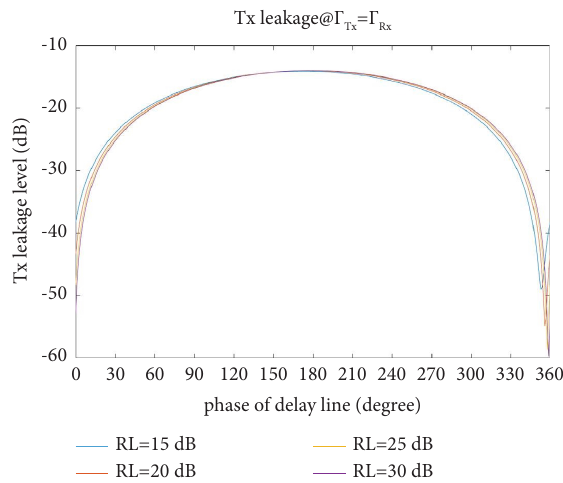
Figure 4: Tx leakage levels against the phase of the delay line from equation (7).